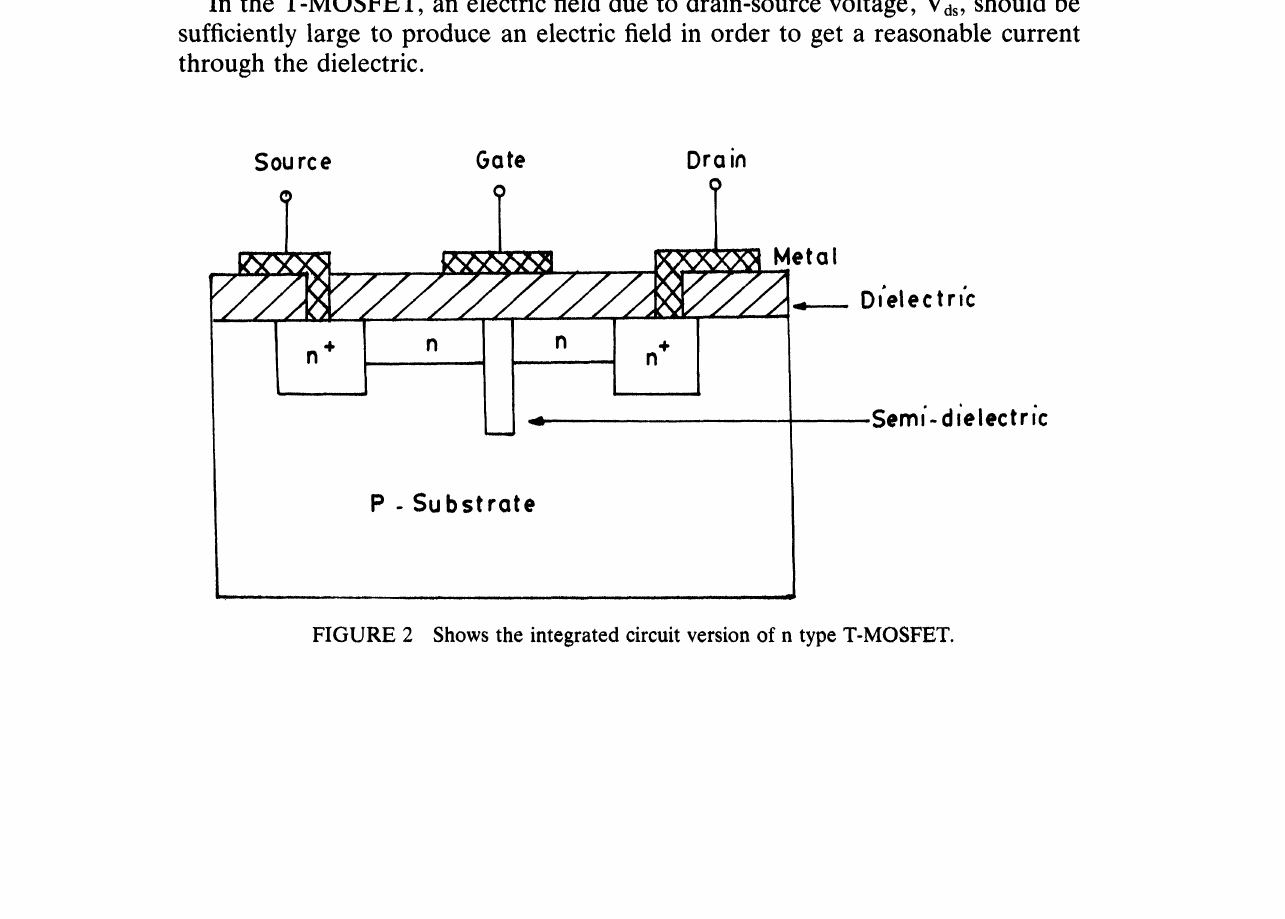
" Semi’- dielect r ic FIGURE Shows the T-MOSFET